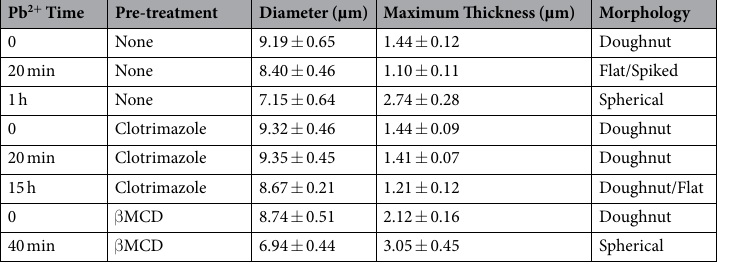
Table 2. Morphological changes induced by Pb 2 + on RBC. Overview of the AFM data. Mean values ± S.D. (n = 50–200 cells, through 3 different experiments).